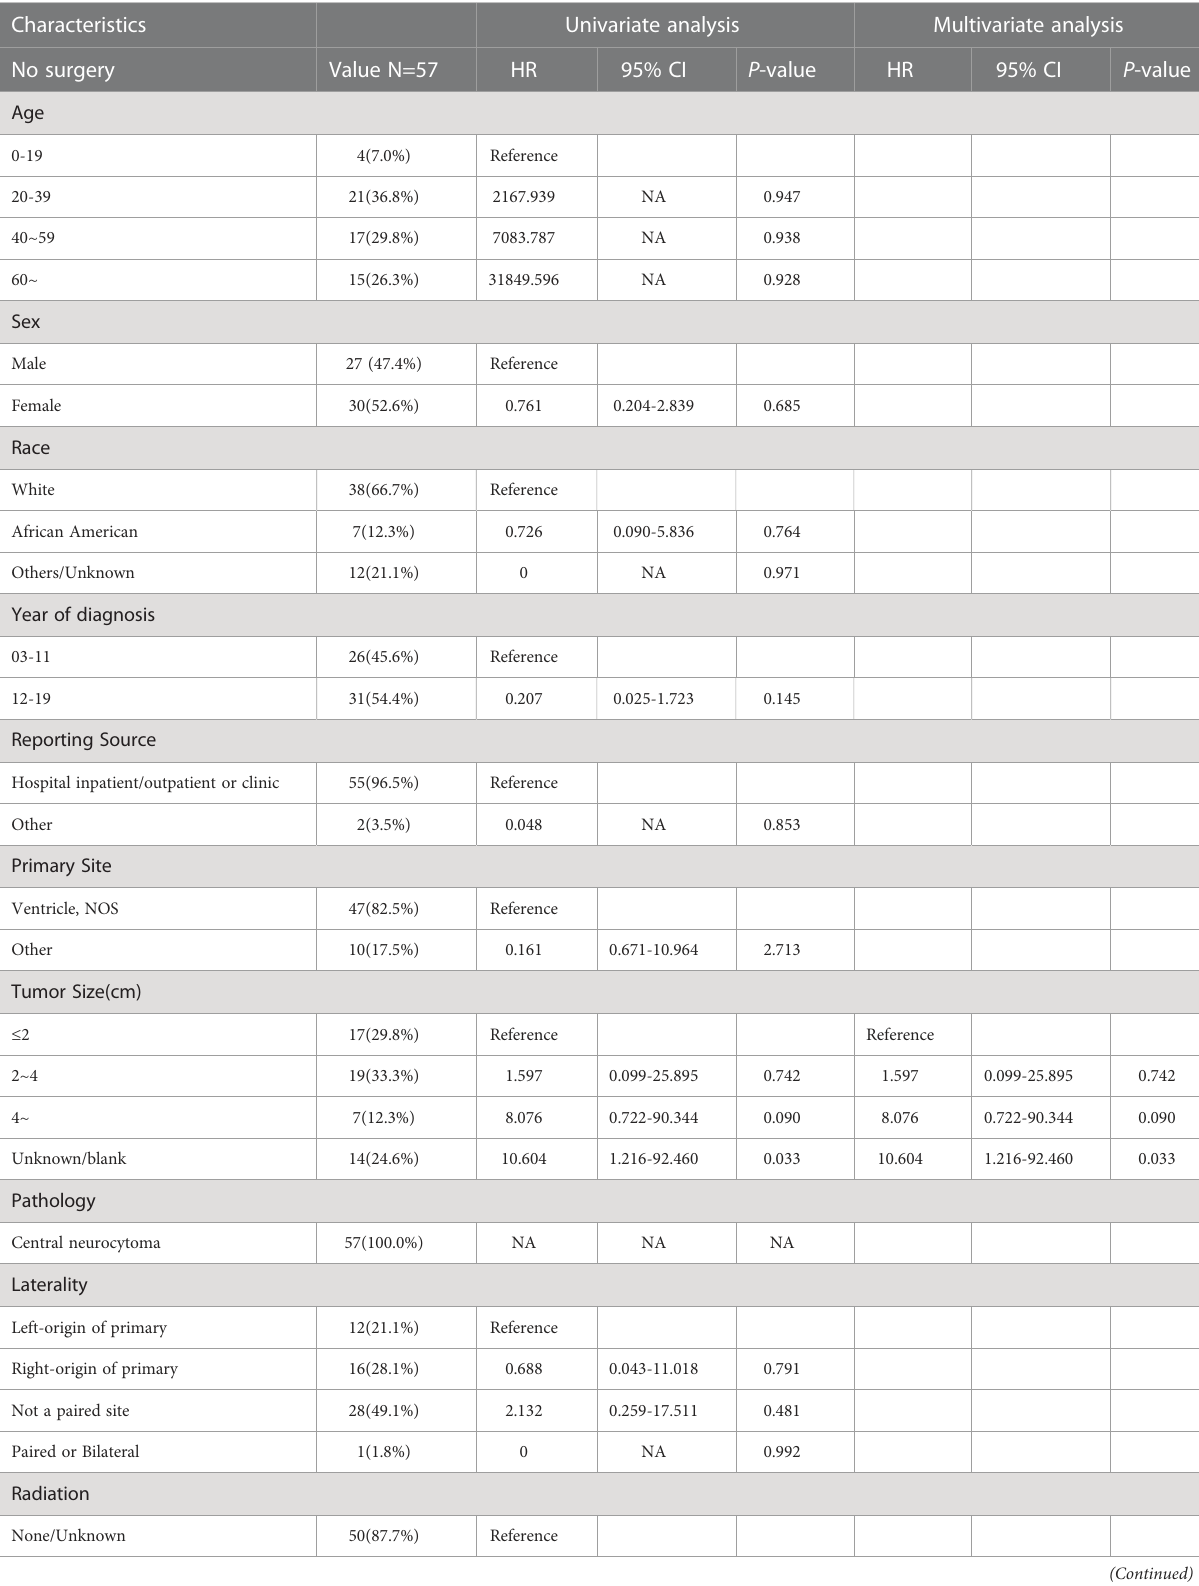
TABLE 4 The median overall survival (OS) of the no surgery subgroup was 46 (interquartile range (IQR): 16.5 – 108)